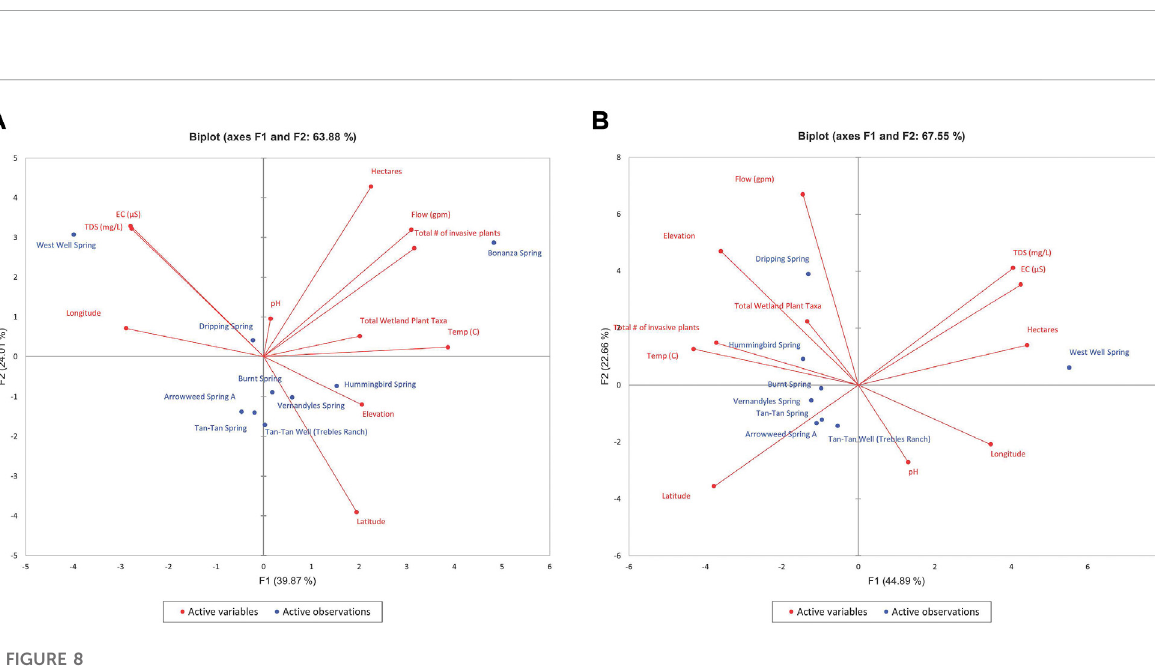
FIGURE 8 PCA biplot of F1 and F2 for ecohydrological dataset for the Southeastern Desert region (A) Bonanza Spring included, (B) Bonanza Spring